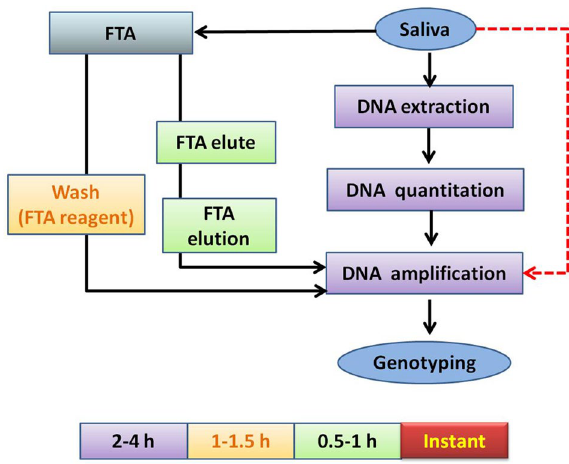
Figure 1. Workflow of conventional forensic DNA